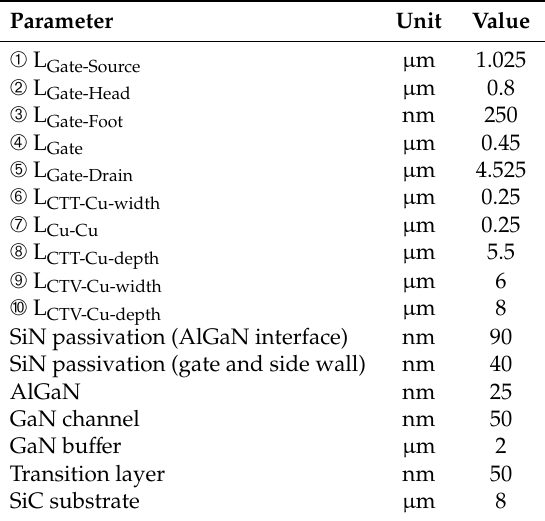
Figure 2. AlGaN / GaN HEMT structure: ( a ) basic AlGaN / GaN on SiC, ( b ) copper-filled thermal trench, and ( c ) copper-filled thermal via in the SiC substrate. Table 1. Geometrical parameters for basic GaN on SiC (BGS), copper-filled thermal trench (CTT), and copper-filled thermal via (CTV) structures.